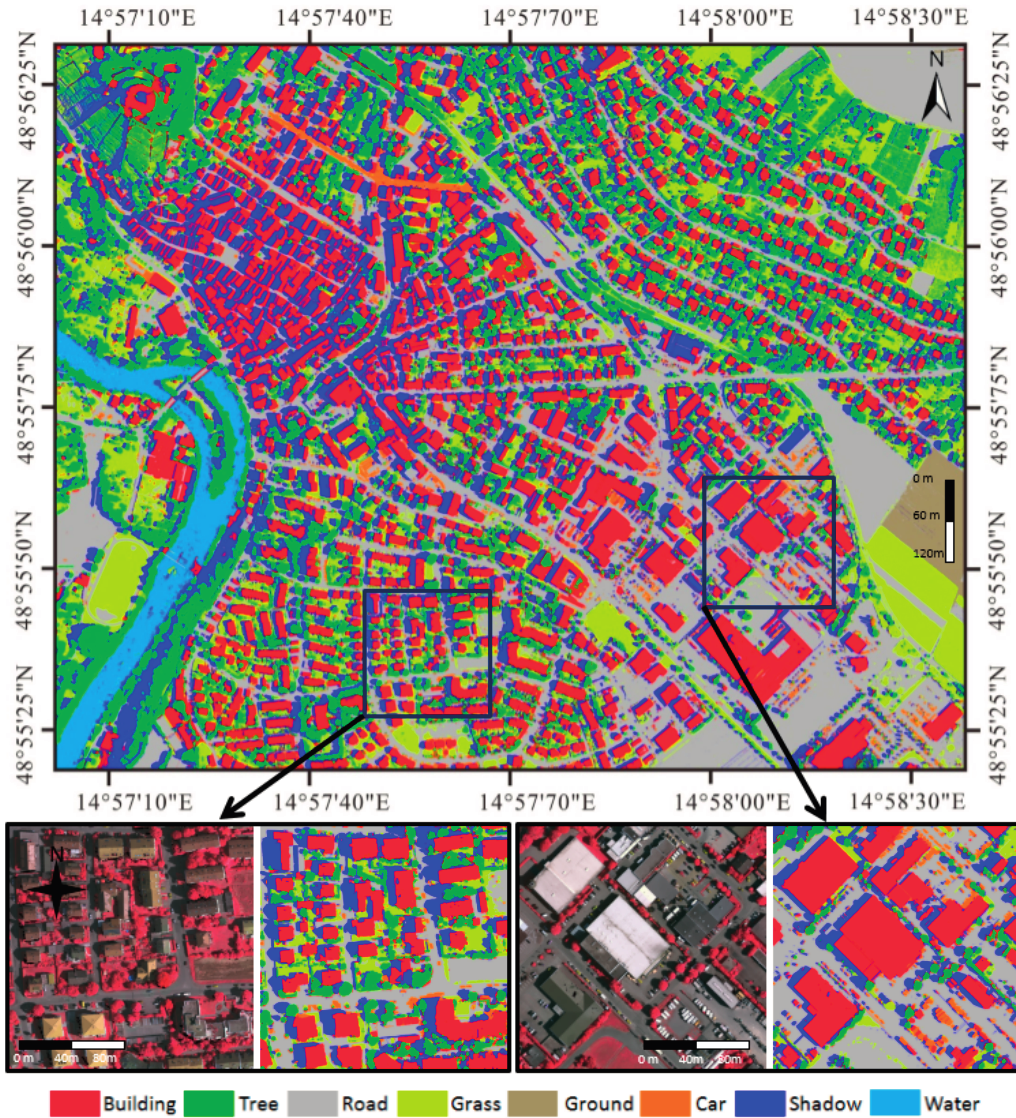
Figure 7. Qualitative experimental results the whole Vaihingen dataset. Two zoom-in areas are shown for a visual